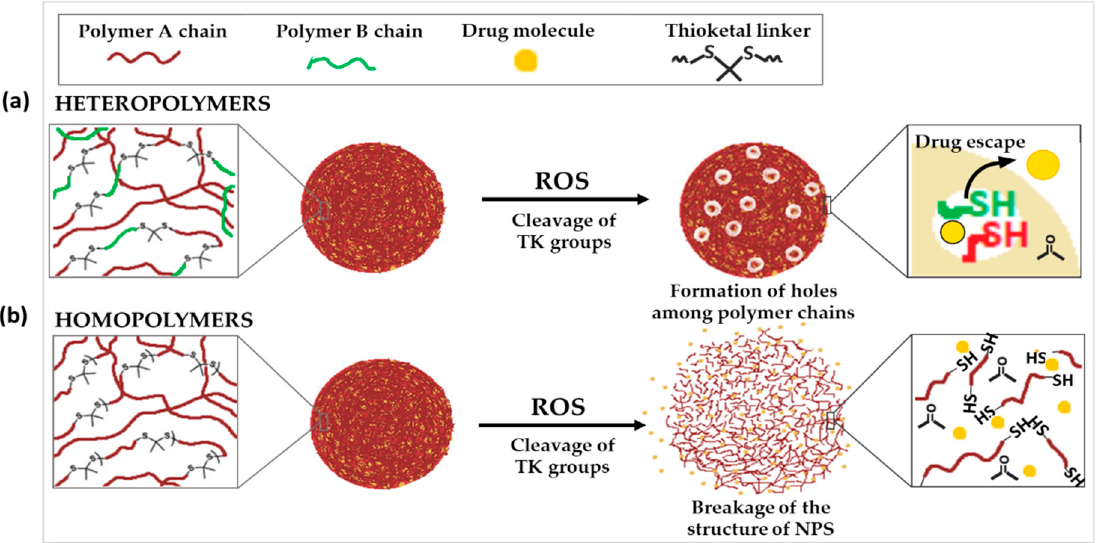
Figure 3. Schematic illustration of the chemical structure and corresponding release mechanisms of TK-based ROS-responsive nanosystems, where TK is incorporated into ( a ) heteropolymers, two polymers with different physico-chemical characteristics or ( b ) homopolymers.